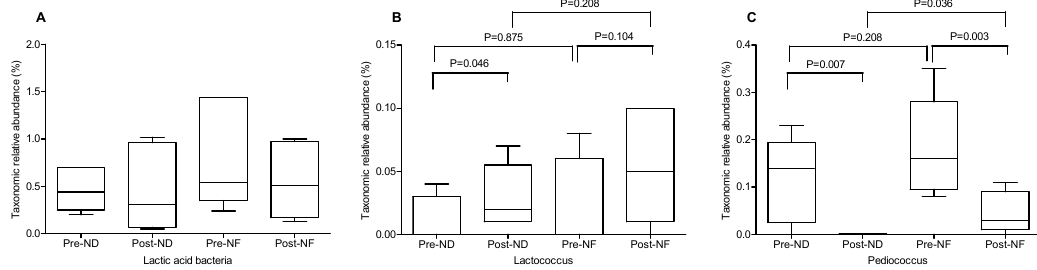
Figure 6. Genus differences within and between groups. ND (control serum); NF (cosmetic serum containing GOS). Figure 6. The relative abundances of Lactic acid bacteria ( A ), Lactococcus ( B ) and Pediococcus ( C ) in the four groups. ND (control serum); NF (cosmetic serum containing